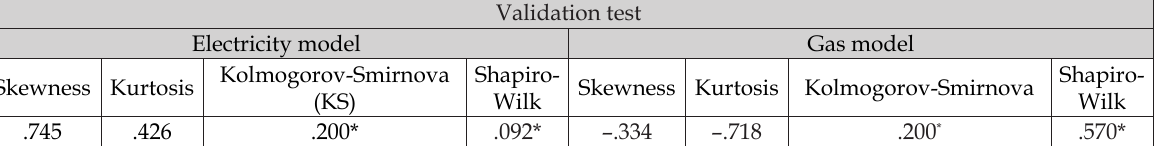
Table 3. Normality tests of the